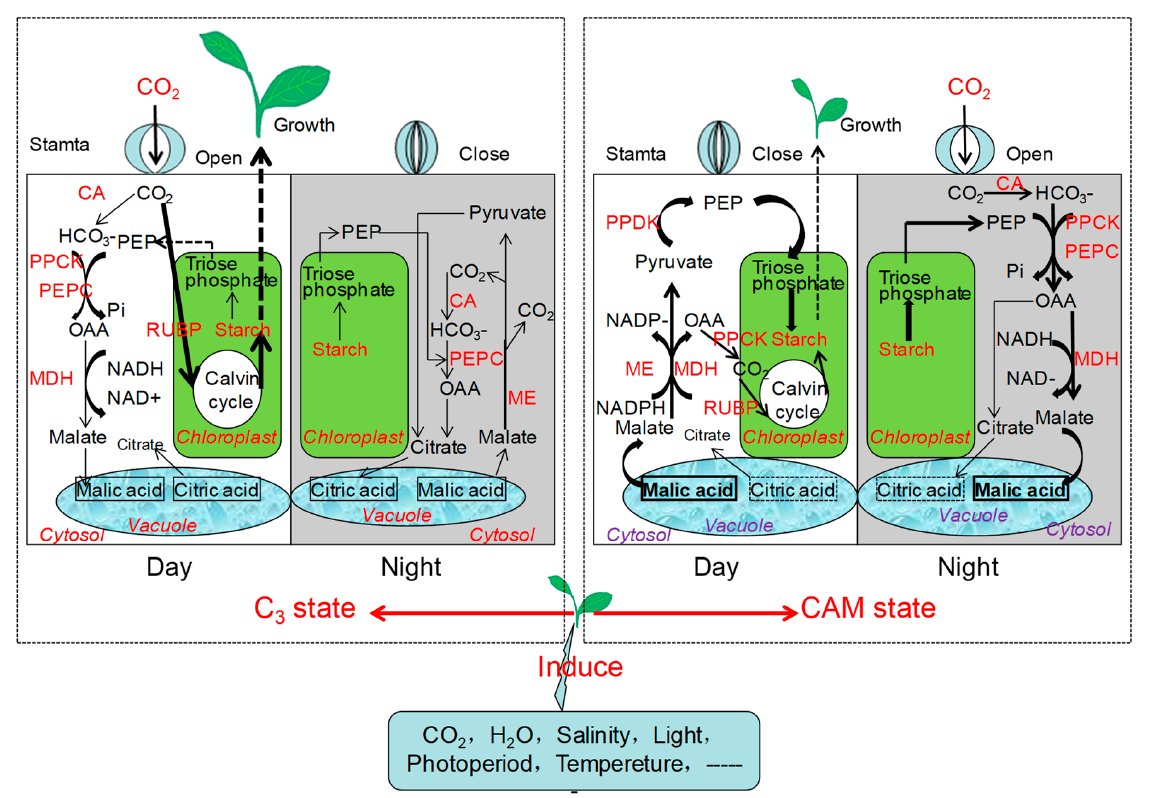
Figure 1. Physiological and Metabolic shift of the facultative CAM plants from C 3 to CAM photo- synthesis. For the facultative CAM plants, C 3 state of photosynthesis is used to fix CO 2 under well conditions, when stomata open during the day and close at night. Once the facultative CAM plants stressed by abiotic stress (such as atmospheric CO 2 concentration, drought, salinity, photoperiod, light, etc.), the carbon assimilation pathway will be induced to the CAM mode, when CO 2 uptakes during the nighttime via open stomata and stores as organic acids (mainly malic acid). Then, organic acids are decarboxylated in the vacuoles during the daytime and CO 2 is refixed via Calvin cycle. CA, Carbonic anhydrase; PEP, Phosphoenol pyruvate; PEPC, Phosphoenolpyruvate carboxylase; PPCK, PEPC kinase; PPDK, Pyruvate phosphate kinase; ME, Malic enzyme; MDH, Malic dehydrogenase; OAA, Oxalacetic acid; RUBP, Ribulose-1,5-bisphosphate carboxylase; NAD, Nicotinamide adenine denucleotide; NADP, Nicotinamide adenine denucleotide phosphate.